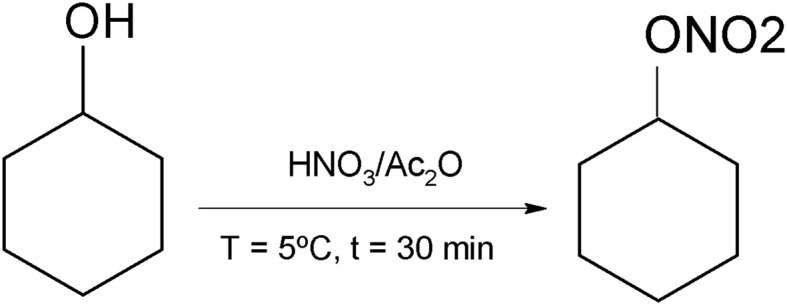
Synthetic route for obtaining the cyclohexane nitrate (HEX).